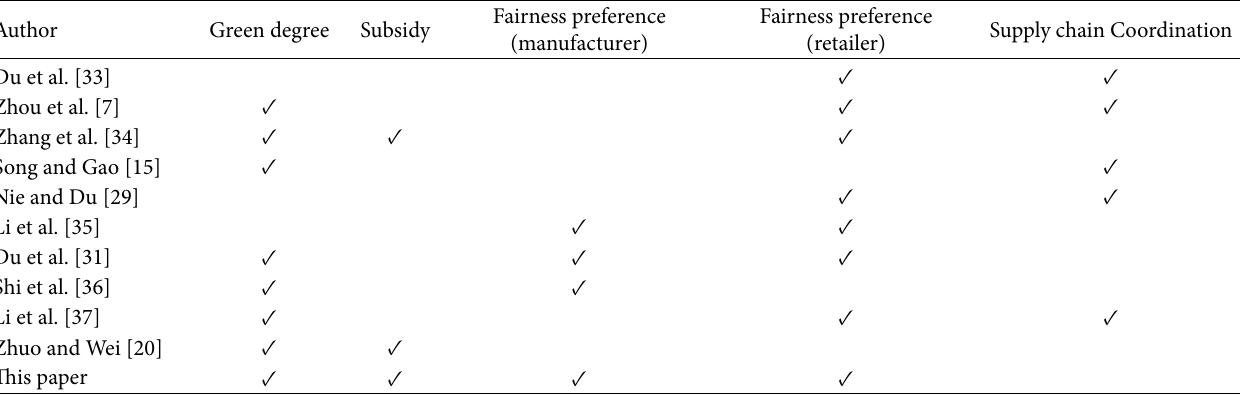
Table 1: Some literature most relevant to this